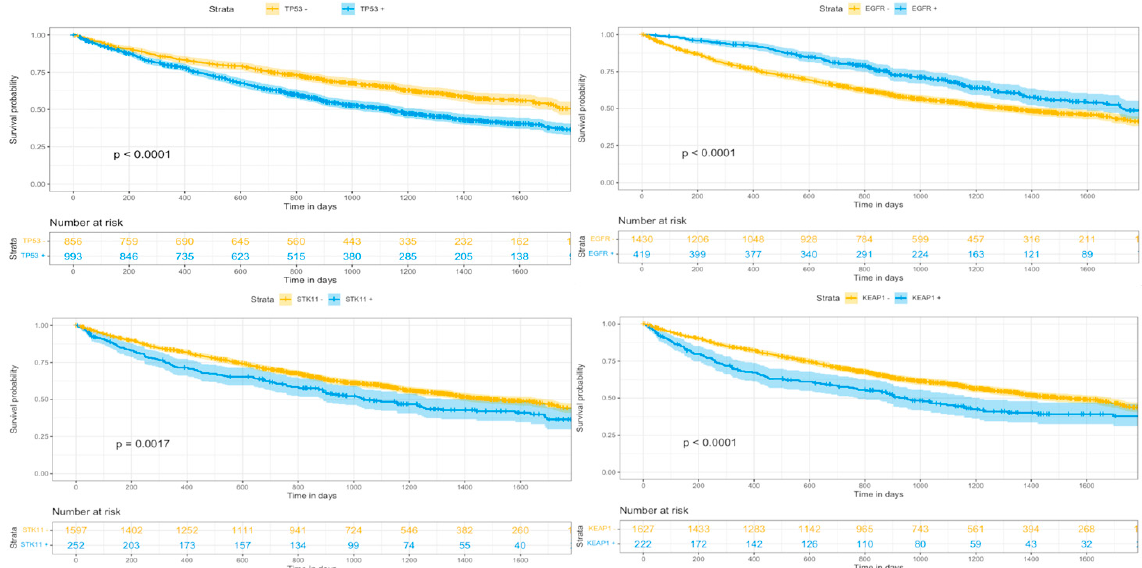
Figure 1. Overall survival curves for significant genetic markers in all patients.